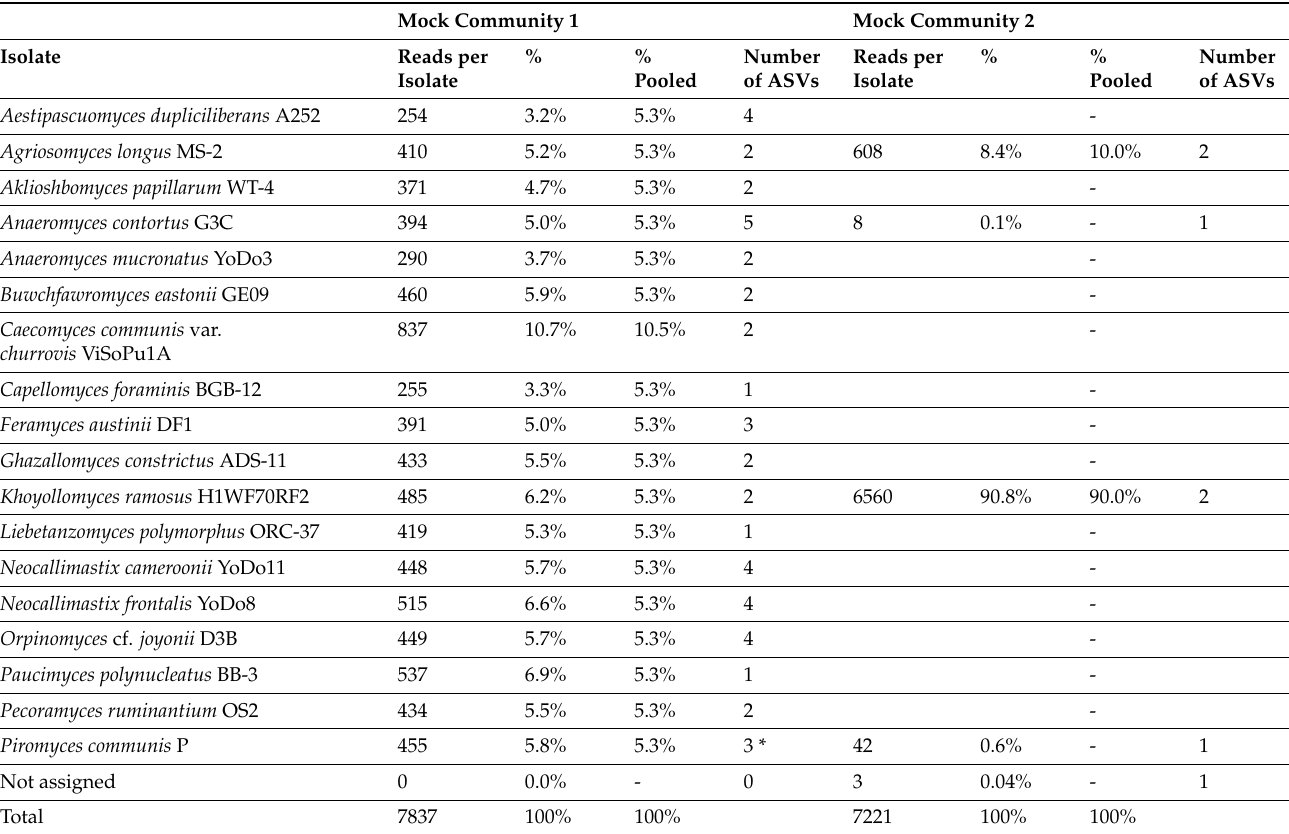
Table 4. Composition of mock communities prepared of pooled LSU D2 Illumina amplicons